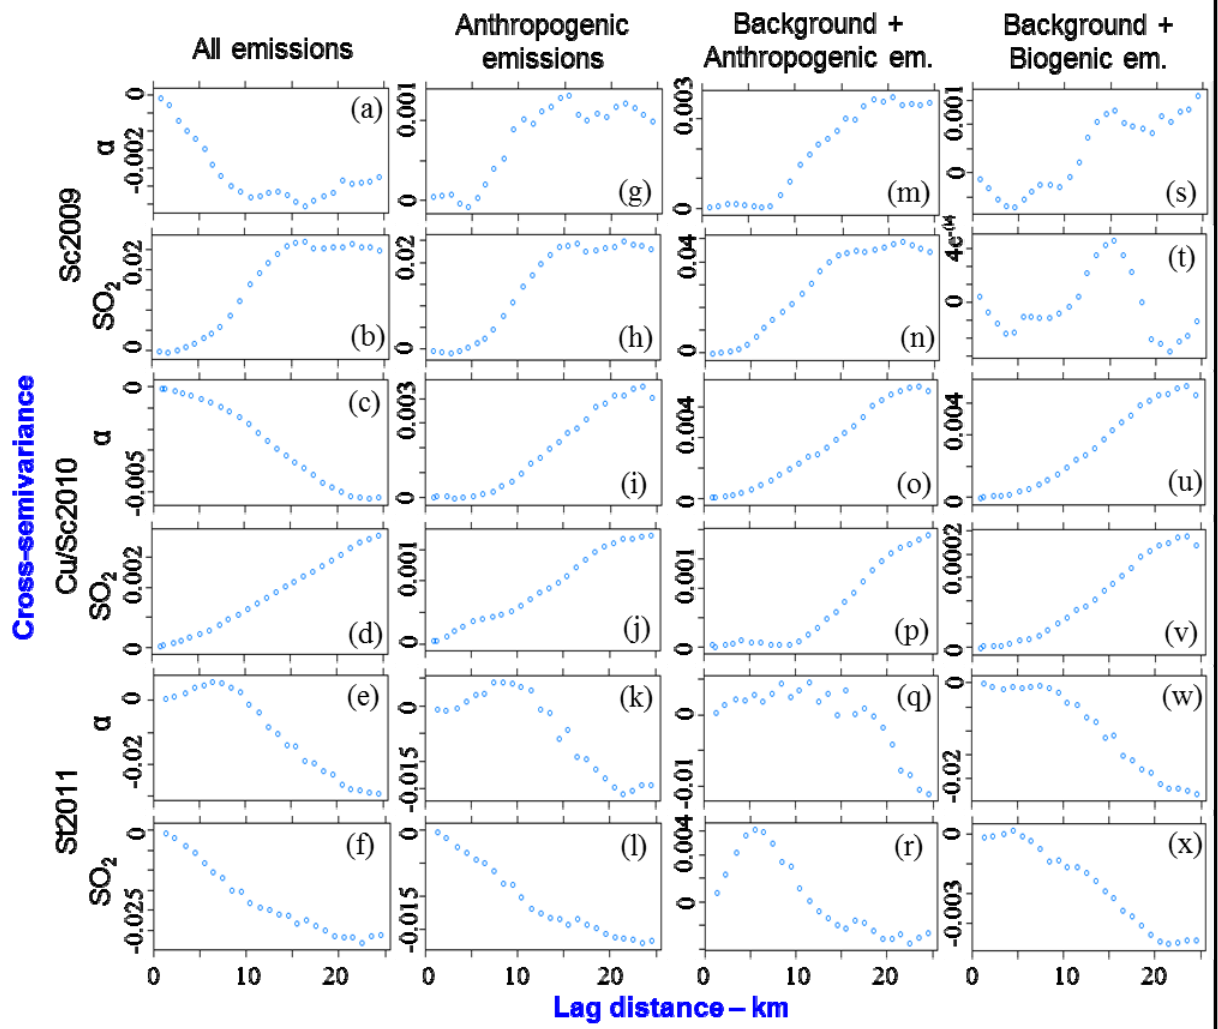
Figure 8. Cross-variograms for three rain events and four model configurations indicating the spatial correlation of logarithm transformed parameters—rain rate with both Angstrom exponent ( α ) and SO emissions: Sc2009 ( a , g , m , s ) α and ( b , h , n , t ) SO 2 ( c , i , o , u ) α and ( d , j , p , v ) SO : St2011 ( e , k , q , w ) α and ( f , l , r , x ) SO 2